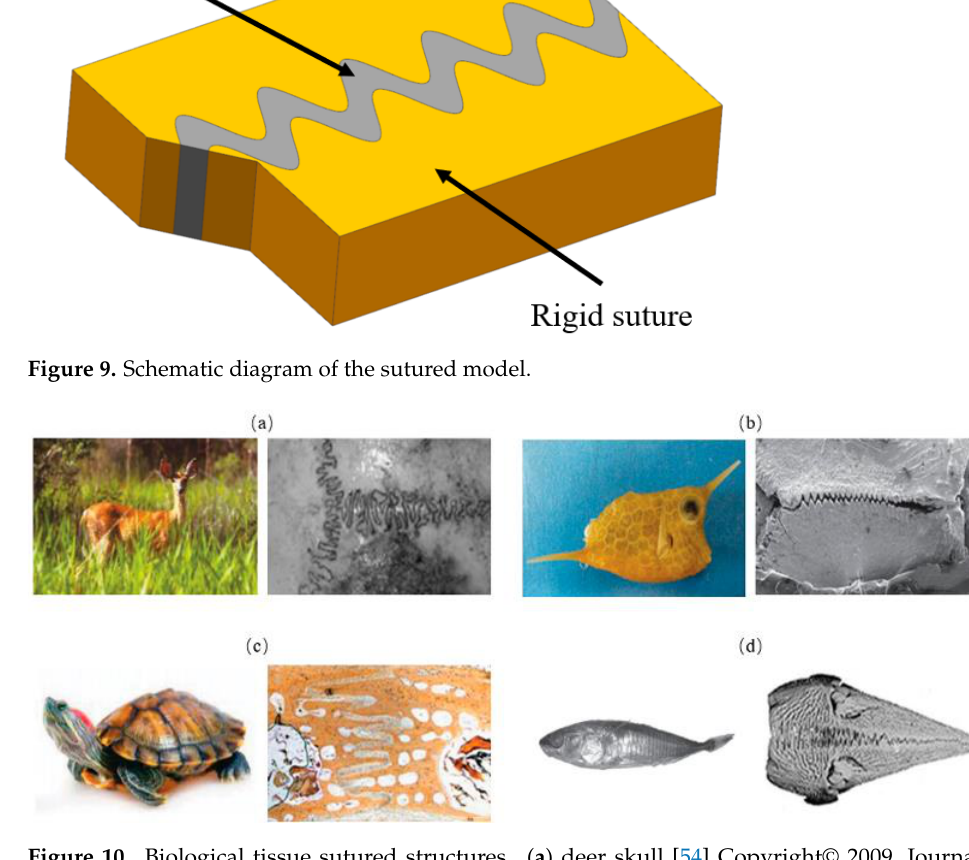
Figure 10. Biological tissue sutured structures. ( a ) deer skull [54] Copyright© 2009, Journal of Mor- phology ( b ) boxfish scales [55] Copyright©2015, Acta Biomaterialia ( c ) turtle shell [56] Copy- right©2009, Advanced Materials ( d ) spiny fish pelvic bone [57]. Copyright©2019, Journal of the Me-